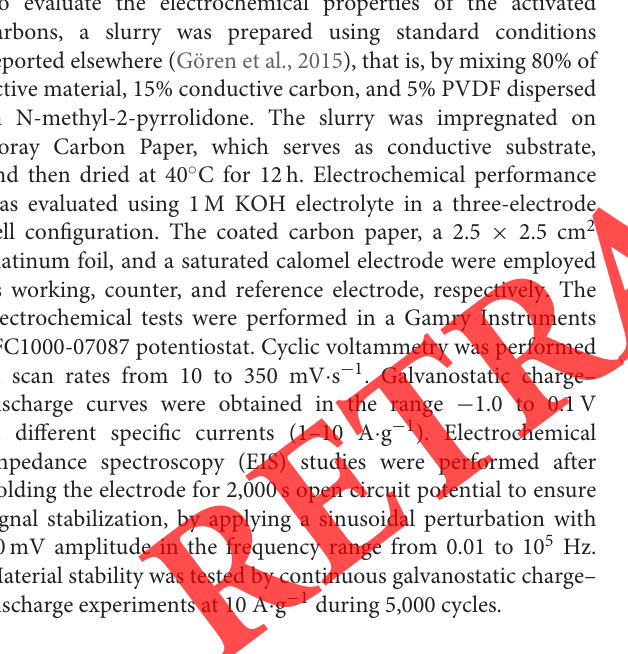
TABLE 1 | Textural properties for both activated carbons obtained from the winemaking